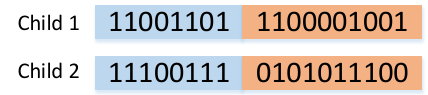
Figure 3. GA crossover